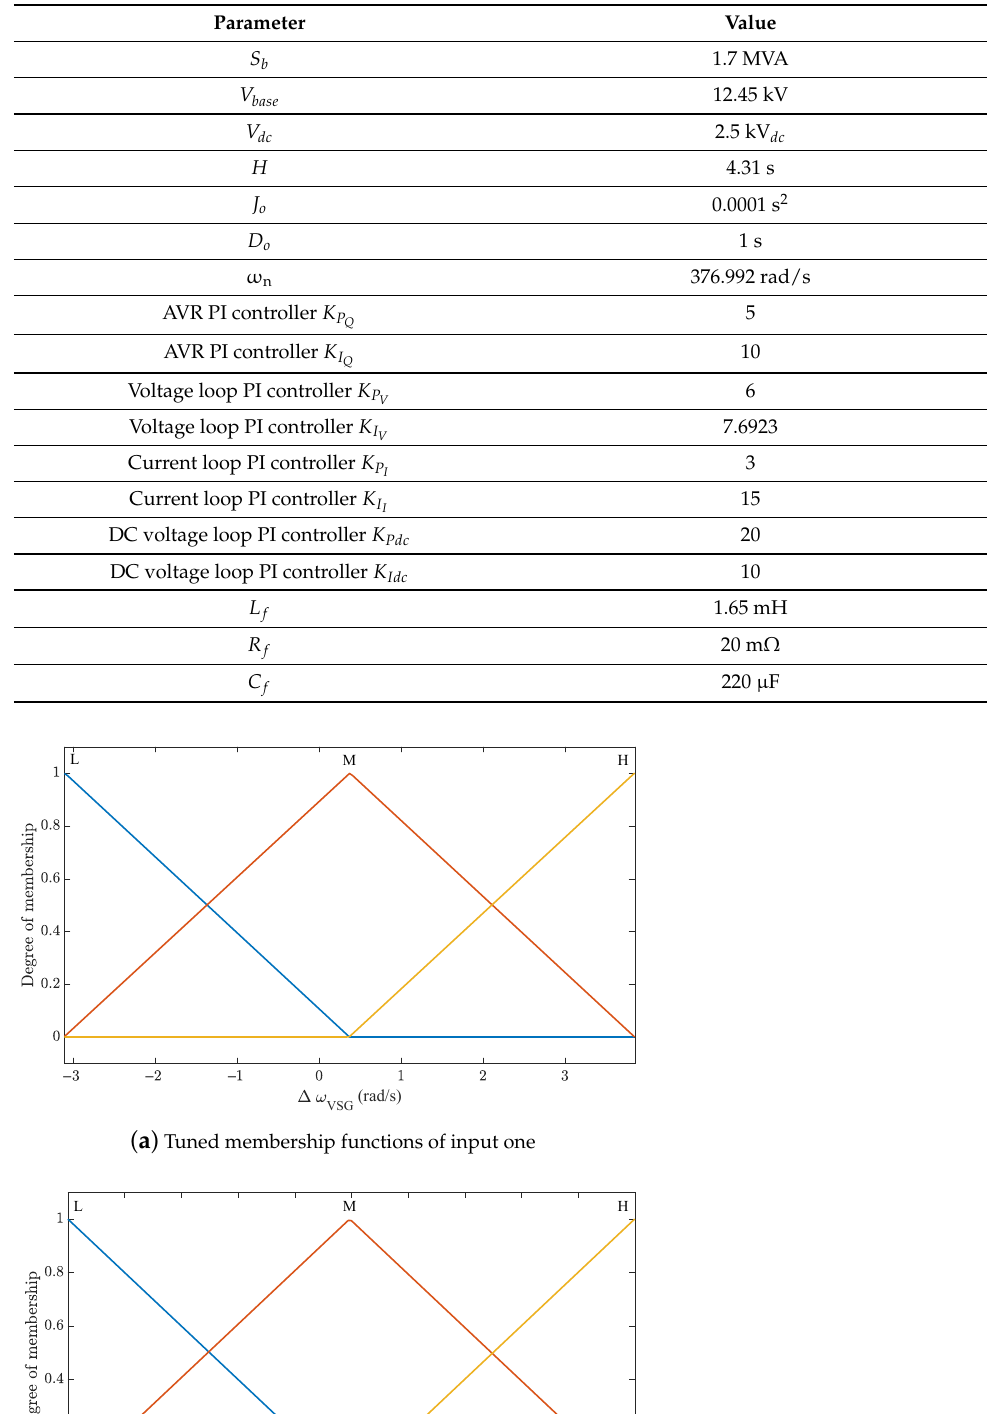
Table 4. VSG DER parameters.